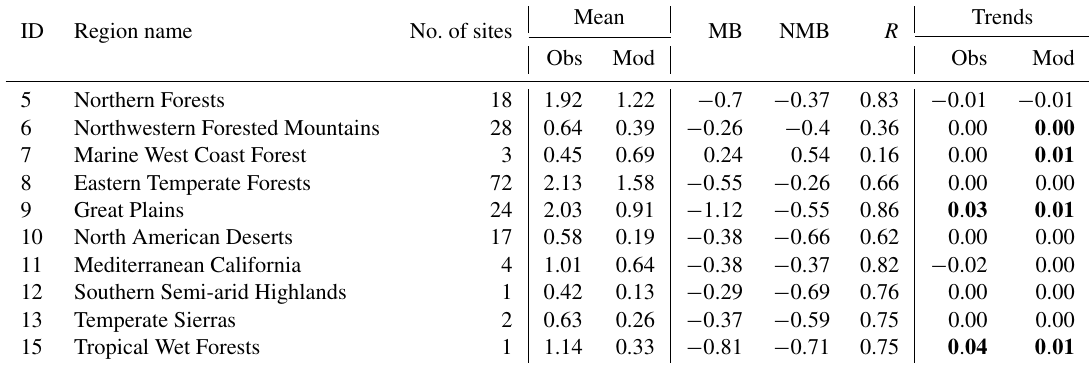
Figure 2. Comparison of the temporal trends for the annual accumulated WDEP (across all the 170 valid sites) for (a) TNO 3 , (b) TNH x , (c) TS, and (d) precipitation, for the eastern US (green, averaged over 141 sites) and western US (red, average over 29 sites) between observations (dashed lines) and annual precipitation-adjusted model values (solid lines). The scale shown on the left is for the eastern US and on the right for the western US. Table 3. The same as Table 2 but for NH